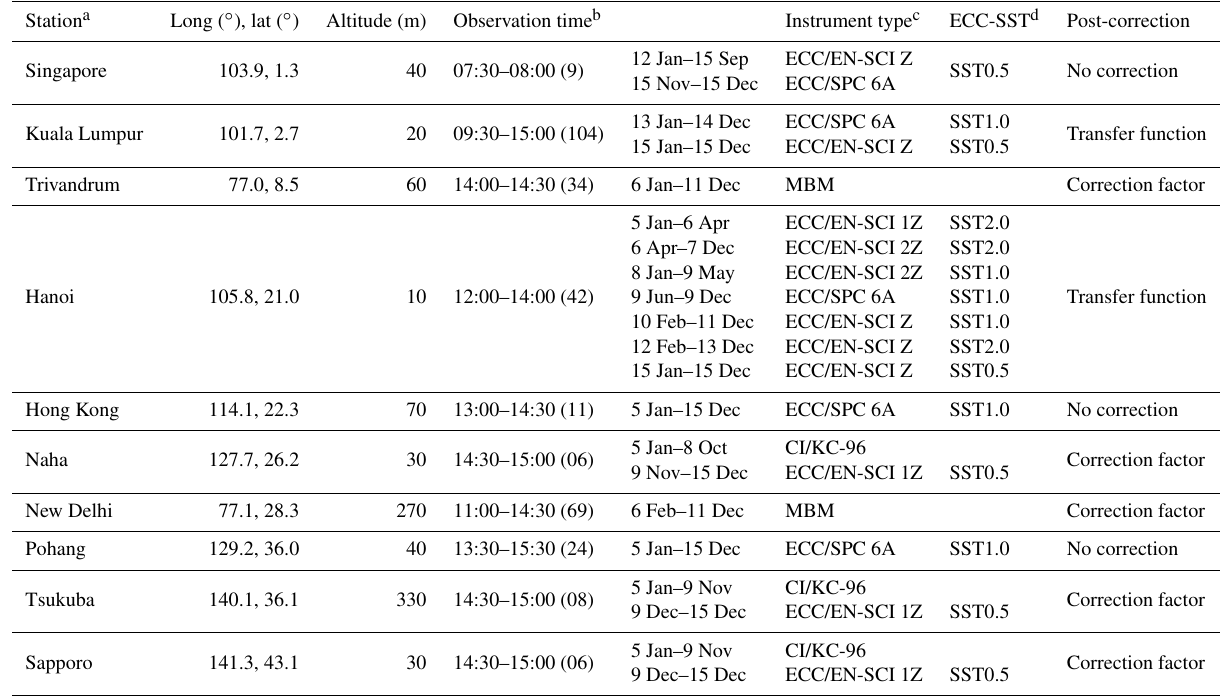
Table 1. List of ozonesonde stations. Station